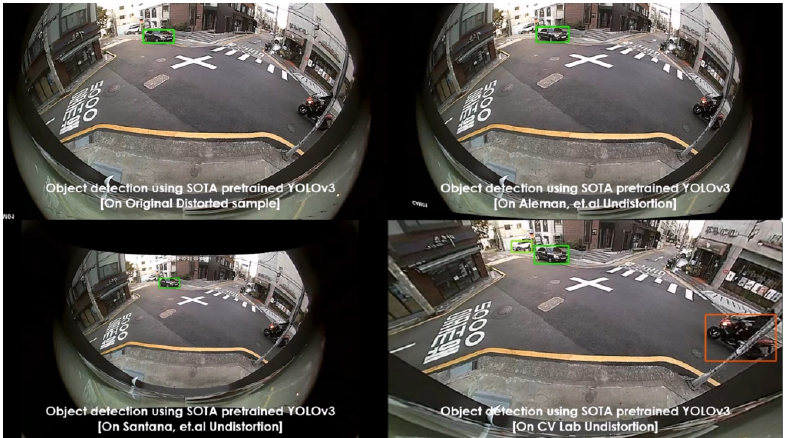
Figure 13. Pretrained YOLOv3 object detection on various rectified 190 ◦ fish-eye frames: motorbike detected along the edge in the proposed rectified